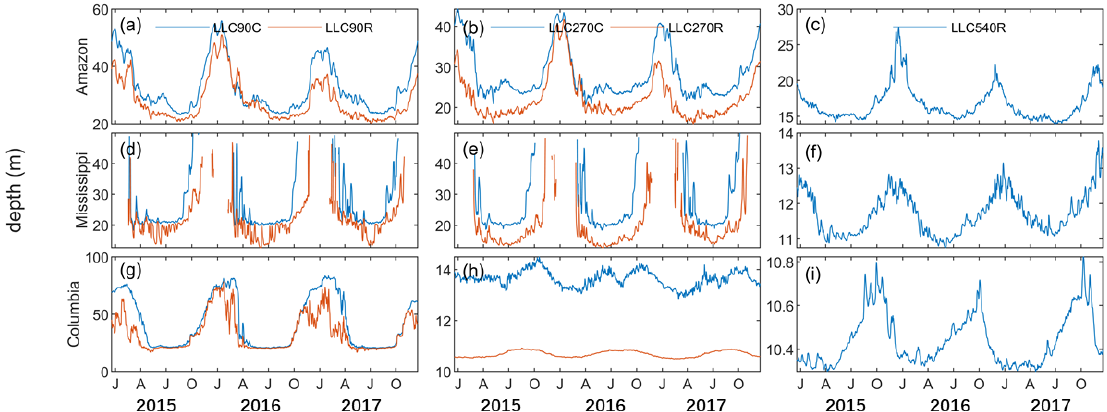
Figure 12. 2015–2017 daily MLD, averaged in the vicinity of the Amazon River (a, b, c) , Mississippi River (d, e, f) , and Columbia River (g, h, i) mouth. MLD is computed based on de Boyer Montegut et al. (2004).